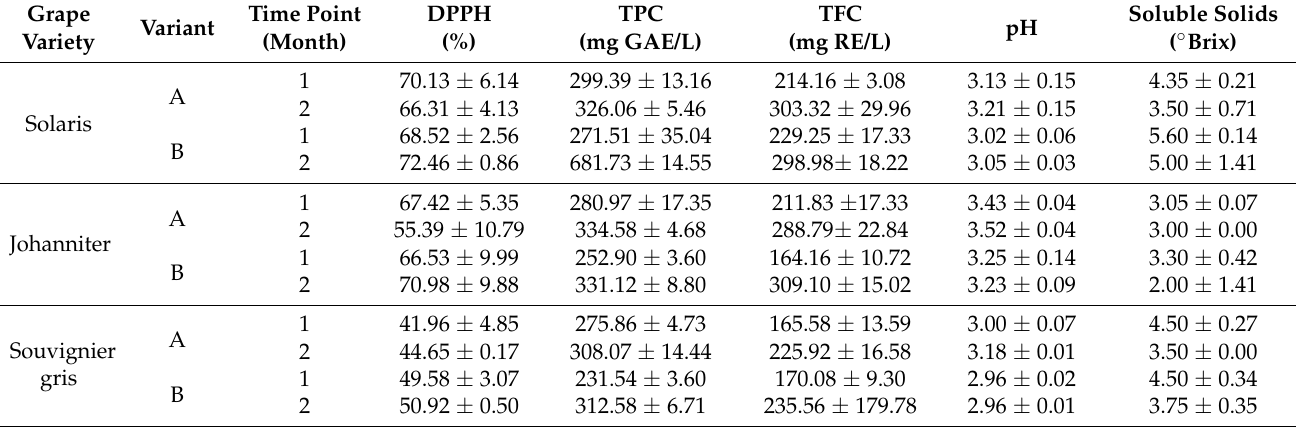
Table 1. Changes in antioxidant potential, Total Polyphenol Content (TPC), Total Flavonoid Content (TFC), pH and content of soluble solids in vinegars during fermentation. The results are presented as mean ± standard deviation of 9 replications.